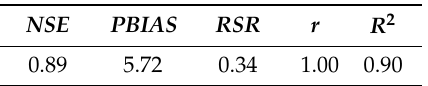
Table 7. Performance rating calculated for the mean signal shown in Figure 19. r = correlation coefficient. R 2 = coefficient of